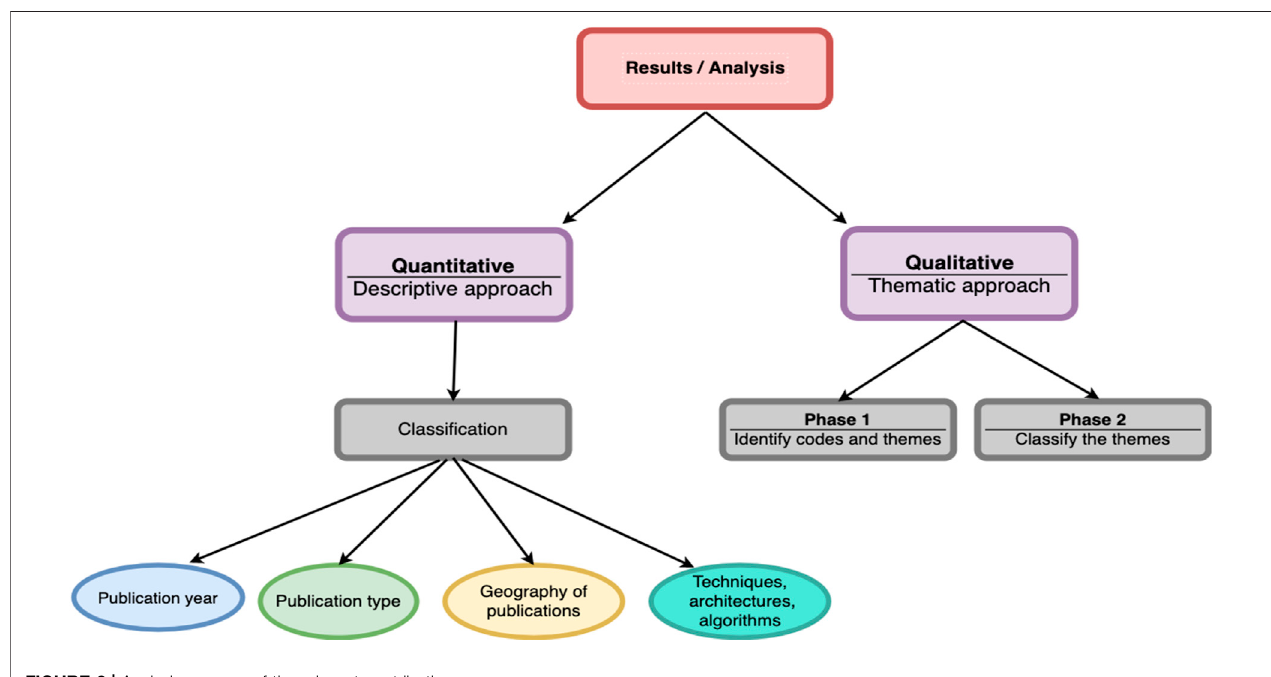
FIGURE 2 | Analysis process of the relevant contributions.